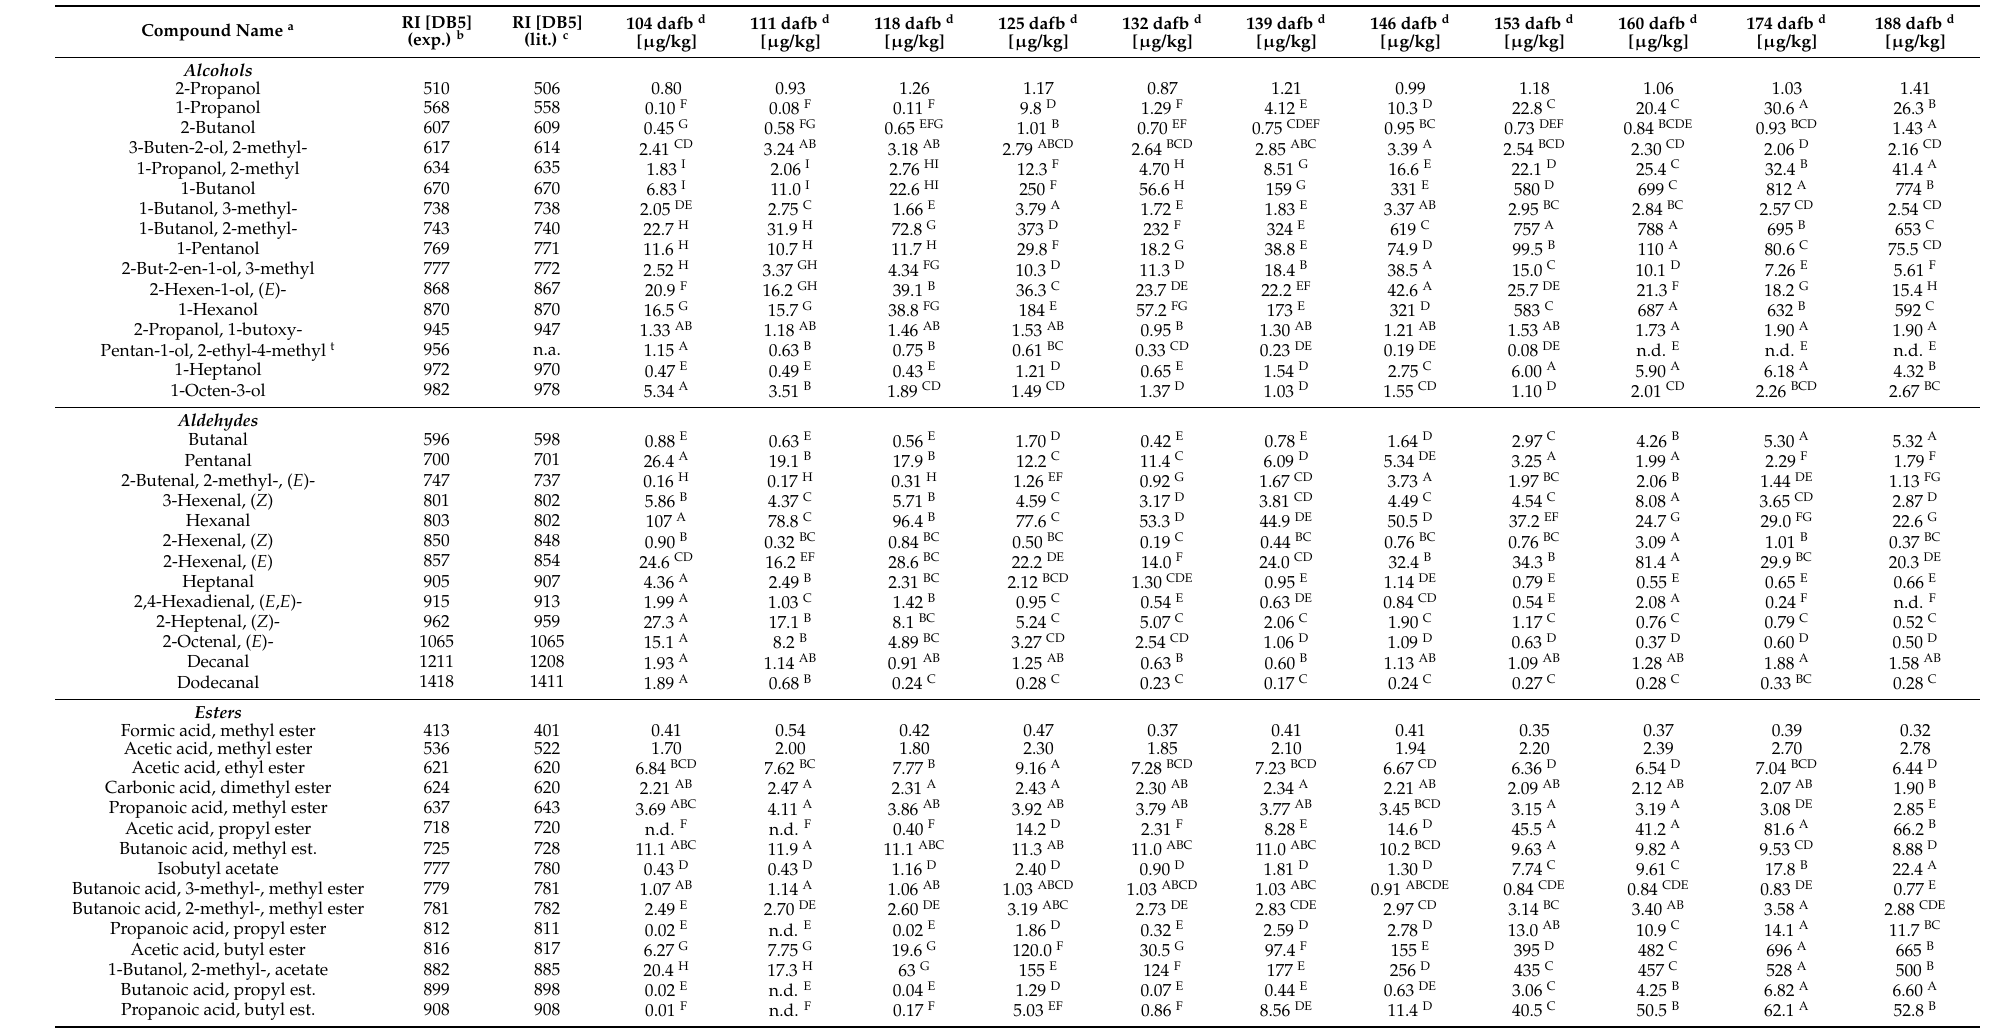
Table 2. Relative concentrations (average values, n = 2, µ g/kg) of the volatile compounds (1 ◦ aroma compounds) identified in fruit pur é e of Crimson Crisp apples after enzyme inactivation harvested at different stages of maturity/ripeness (104–188